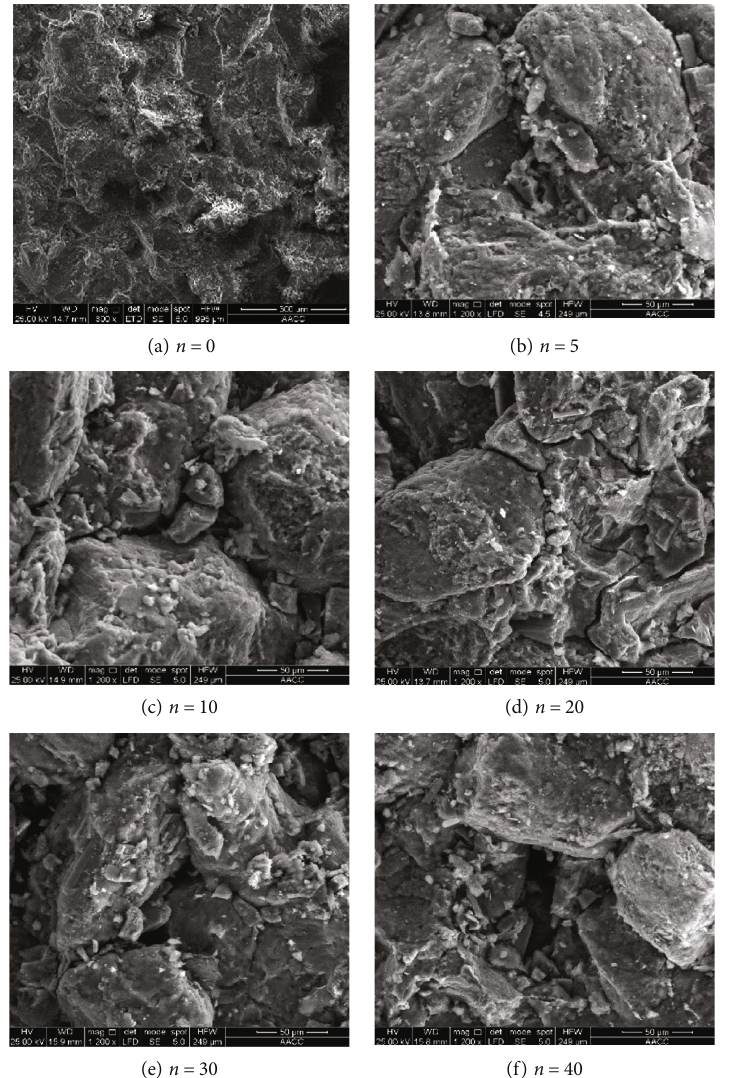
Figure 7: SEM images of micromorphology when pH = 7